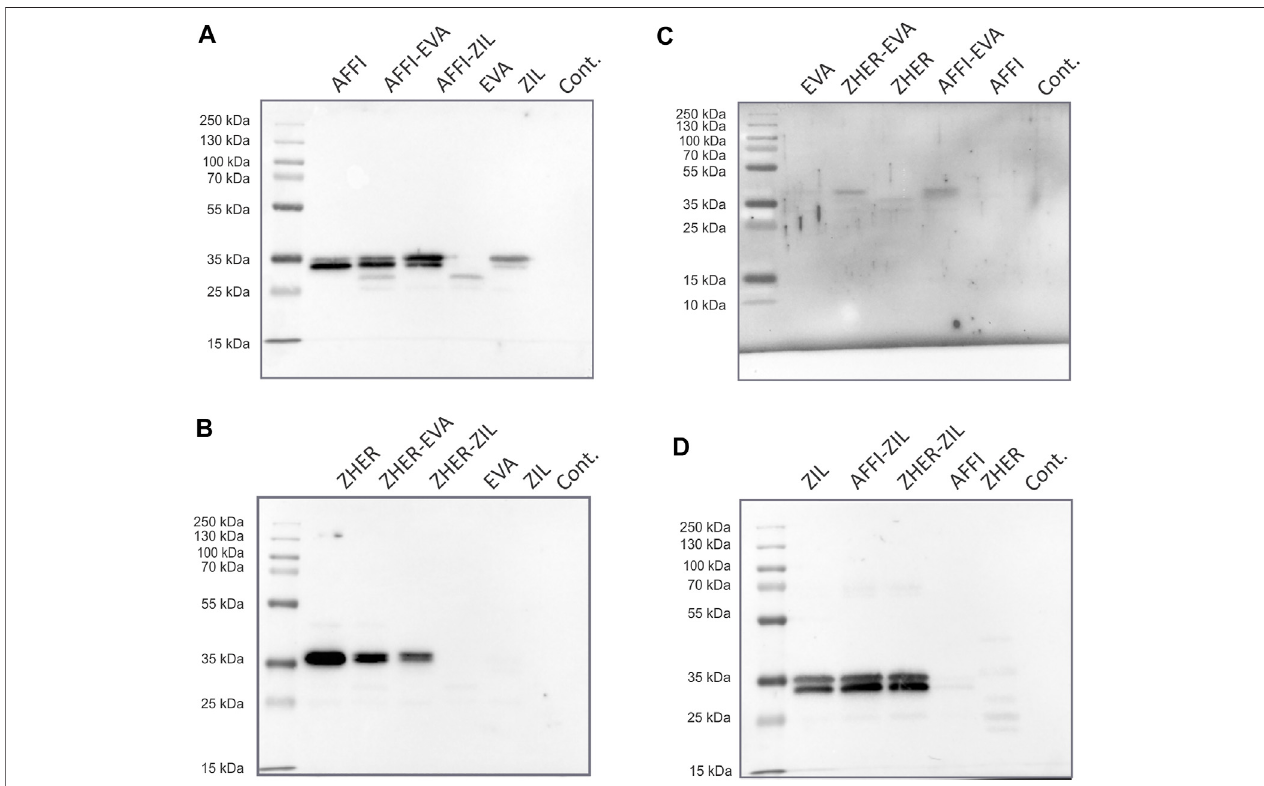
FIGURE3| Tumorantigentargetingandcytokinebindingproteinsareco-expressedin L.lactis .DetectionoftumorantigenbindersAFFI (A) orZHER (B) incombination withcytokinebindersEVA (C) orZIL (D) inthecelllysatesofthedual-plasmid-containing L.lactis byWesternblotting.Cont, L.lactis carryingemptyplasmidpNZ8148. L.lactis expressingsinglebinders(harboringpSDplasmids)servedasthepositivecontrol.AllbinderswereexpressedinfusionwiththeUsp45secretionsignalandtheAcmAsurface anchor. The bands at 35 kDa correspond to the calculated molecular weights of the full-length fusion proteins (protein binder ~7 kDa, AcmA ~25 kDa). Recombinant humanreceptorEpCAM/TROP1FcchimeraproteinwasusedfordetectionofAFFIfusionprotein,recombinanthumanreceptorErbB2/Her2Fcchimeraproteinwasusedfor